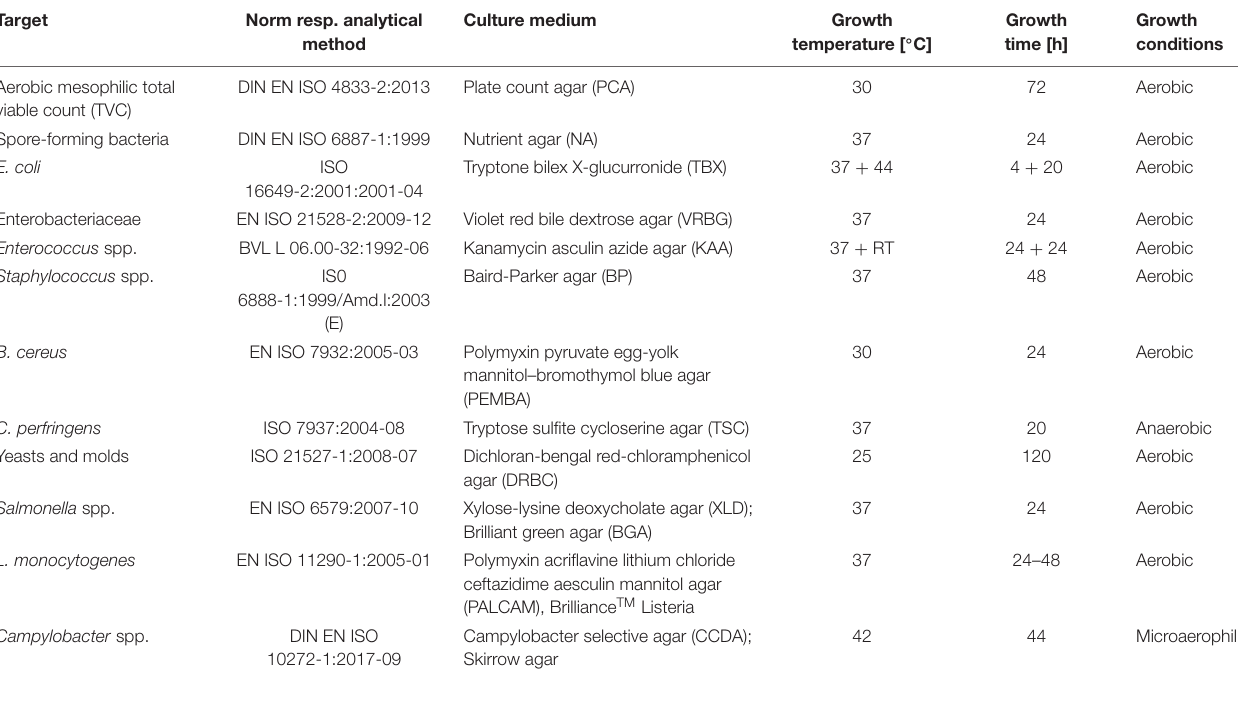
TABLE 1 | European and German standards applied for the evaluation of viable cell counts with corresponding growth parameters.